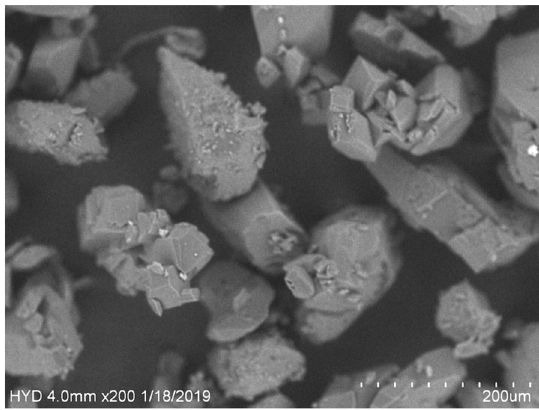
Fig. 11 SEM image of 0.041 g/ml ethanol obtained by solvent evaporation method. Process conditions: 48 h without stir (× 200)